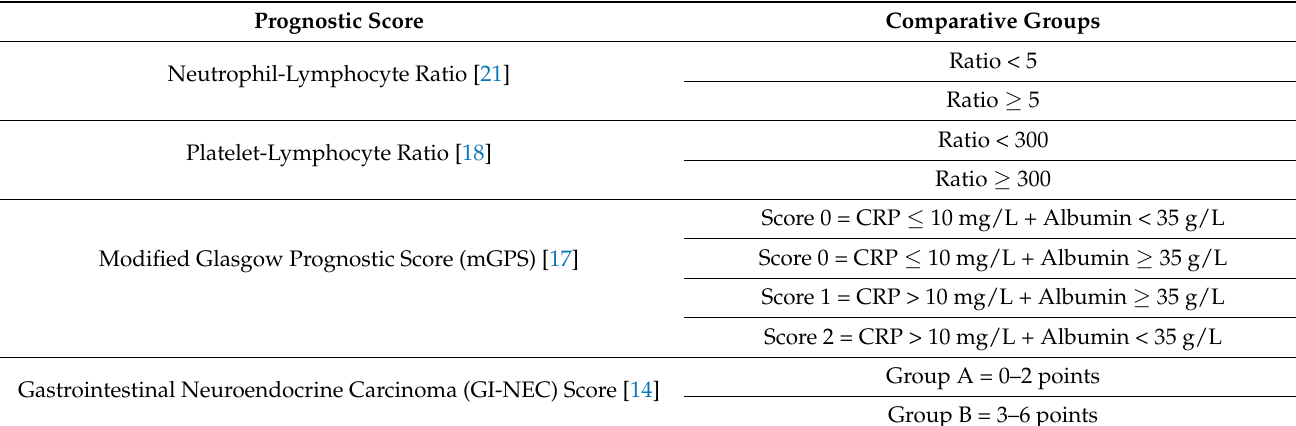
Gastrointestinal Neuroendocrine Carcinoma (GI-NEC) Score [14] Abbreviations: C-Reactive protein (CRP), white blood cell (WBC). Points for the GI-NEC score are allocated for: presence of liver metastases (1), alkaline phosphatase (0 = ≤ 82, 1 = 83–289, 2 = ≥ 290 U/L), lactate dehydrogenase (0 = ≤ 827, 1 = ≥ 828 U/L), Performance status